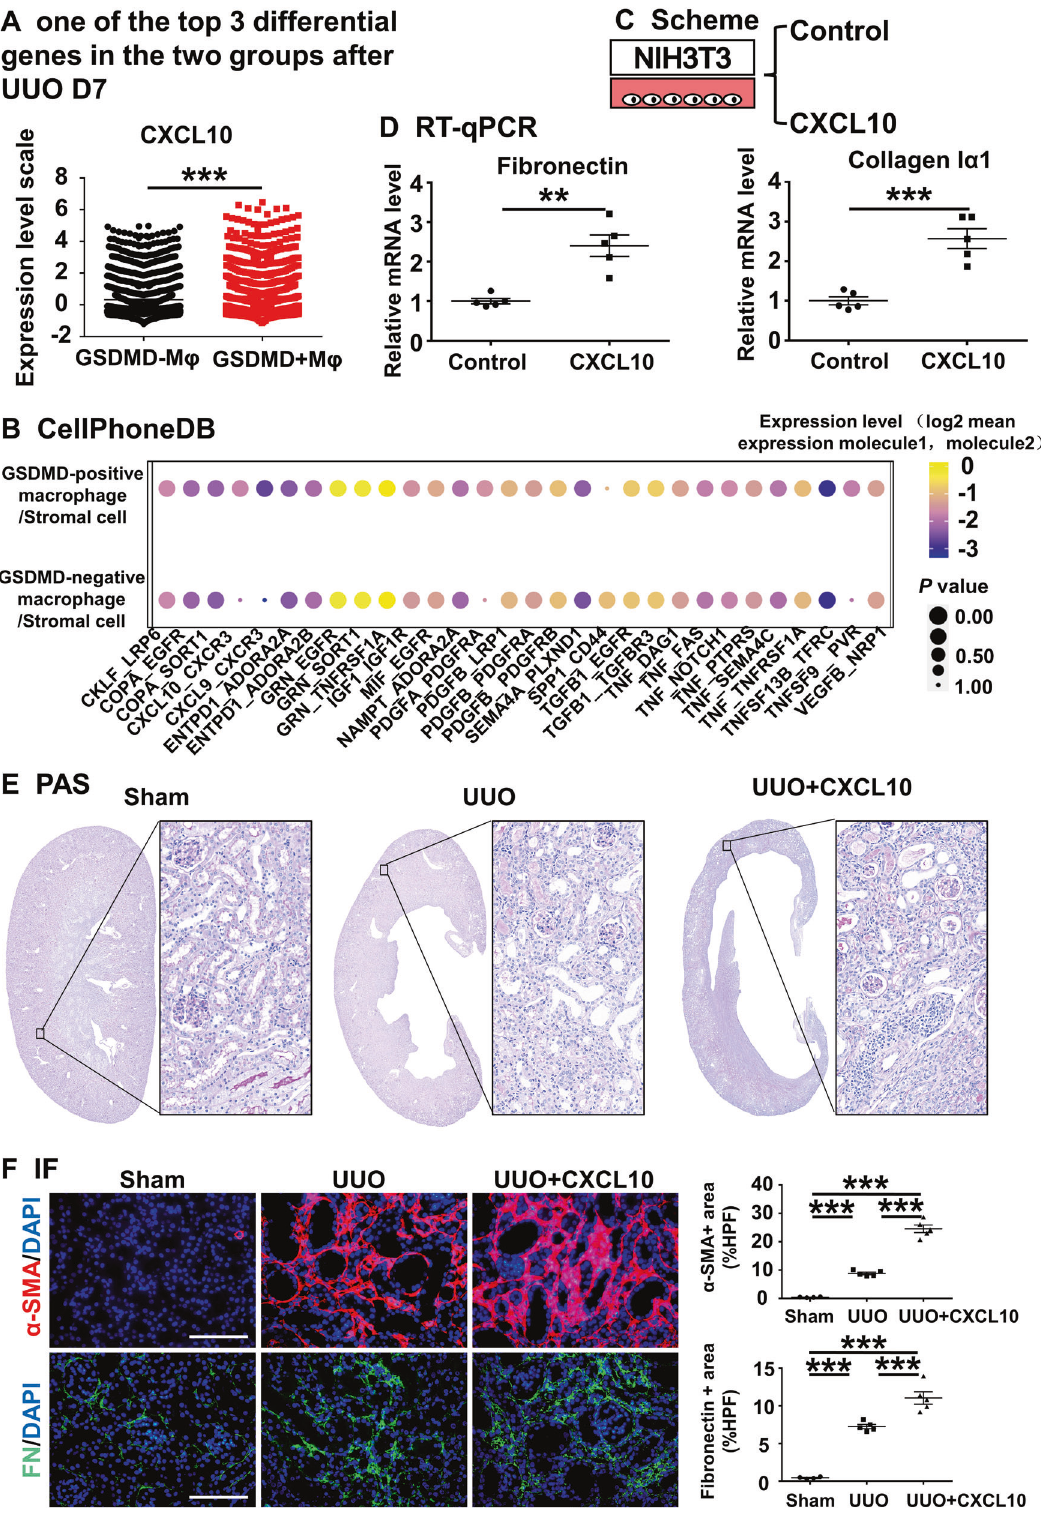
Fig. 8 CXCL10 can aggravate the progression of obstructive nephropathy. A One of the top 3 differential genes between the GSDMD positive macrophage and GSDMD-negative macrophage was CXCL10 by scRNA-seq. B Bubble heatmap showing the mean attraction strength for selected ligand-receptor pairs between the GSDMD-positive/negative macrophage with Stromal cell. Dot size indicates P -value generated by permutation test, colored by attraction strength levels. C Scheme. D Levels of mRNA encoding Fibronectin, collagen I1 α by RT-qPCR. E Representative overall photo and photomicrographs of PAS staining. F Immuno fl uorescence. Representative photomicrographs for immuno fl uorescence labeled α -SMA (red) and FN (green). Corresponding graphs indicate the expression of α -SMA (red) and FN (green). Data are presented as the mean ± SEM, n = 5/group, ** P < 0.01, *** P < 0.001; Scale bar: 100 μ m.